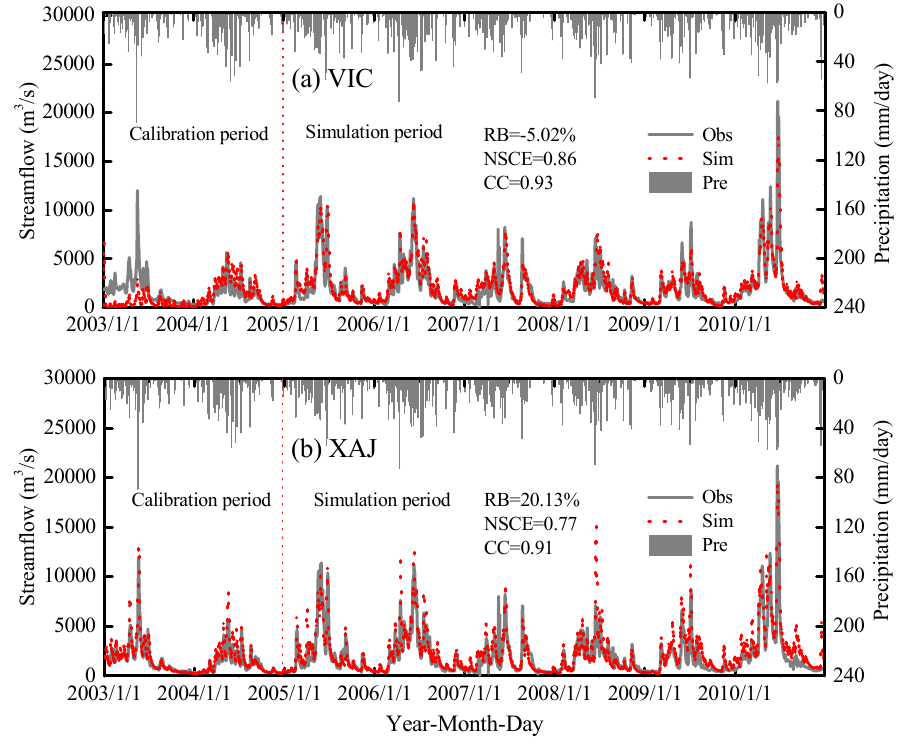
Figure 7. Comparison of observed and simulated streamflow using gauge data as input and corresponding daily precipitation for the calibration period and simulation period (a, VIX; b, XAJ).